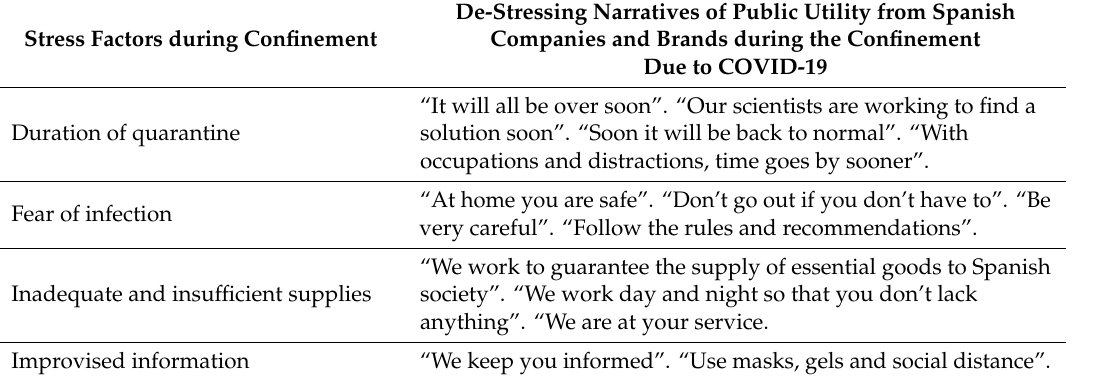
Table 3. Messages to overcome stress factors in audiovisual discursive narratives during isolation. Source: Own elaboration from Brooks et al., 2020 [6].